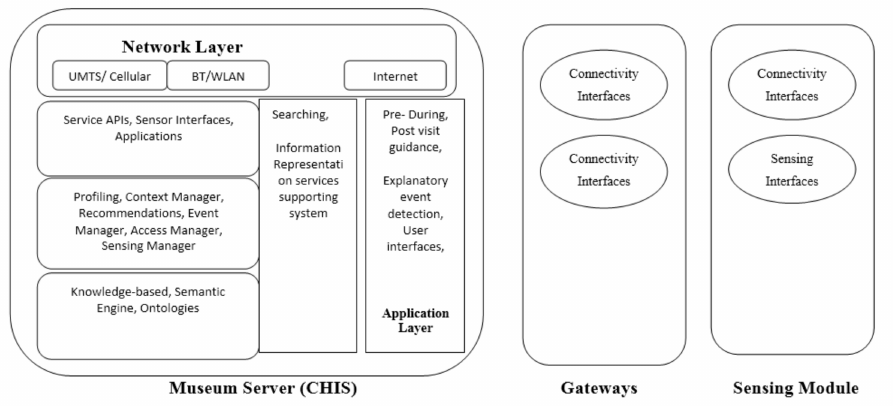
Figure 1. Modified three-layered architecture.